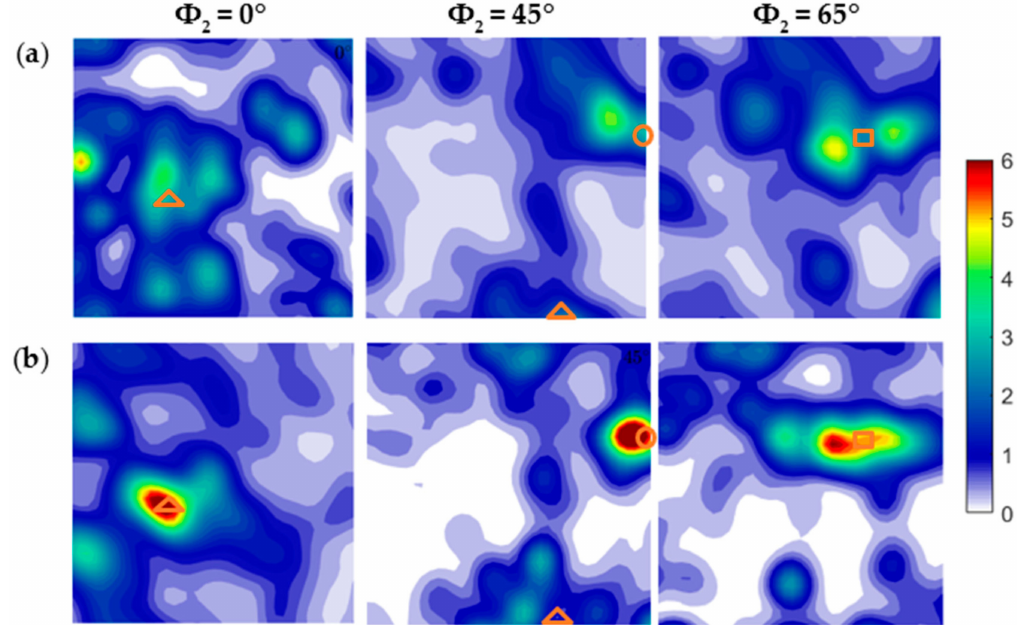
Figure 2. ODF sections of the new Al-6Mg CR20 ( a ) and CR50 alloys ( b ). The triangle represents Brass texture, circle is Copper texture, and the square is used for S